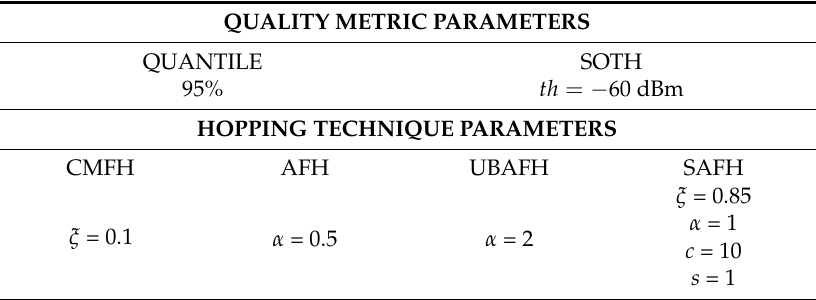
Table 4. Configuration parameters for quality metrics and hopping